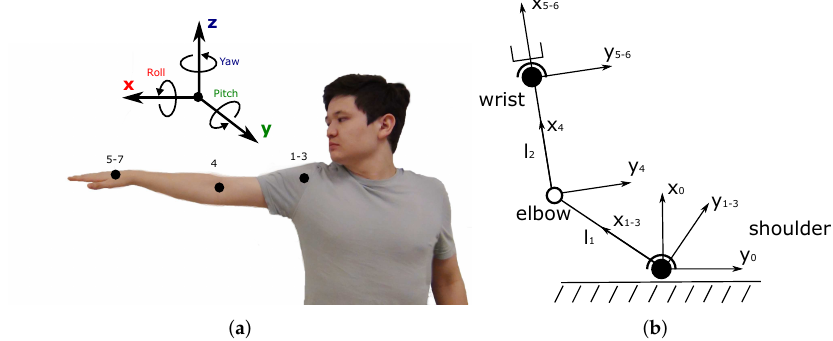
Figure 1. ( a ) A human arm relative to a fixed global frame with indicated DOFs; ( b ) a simplified human arm kinematic